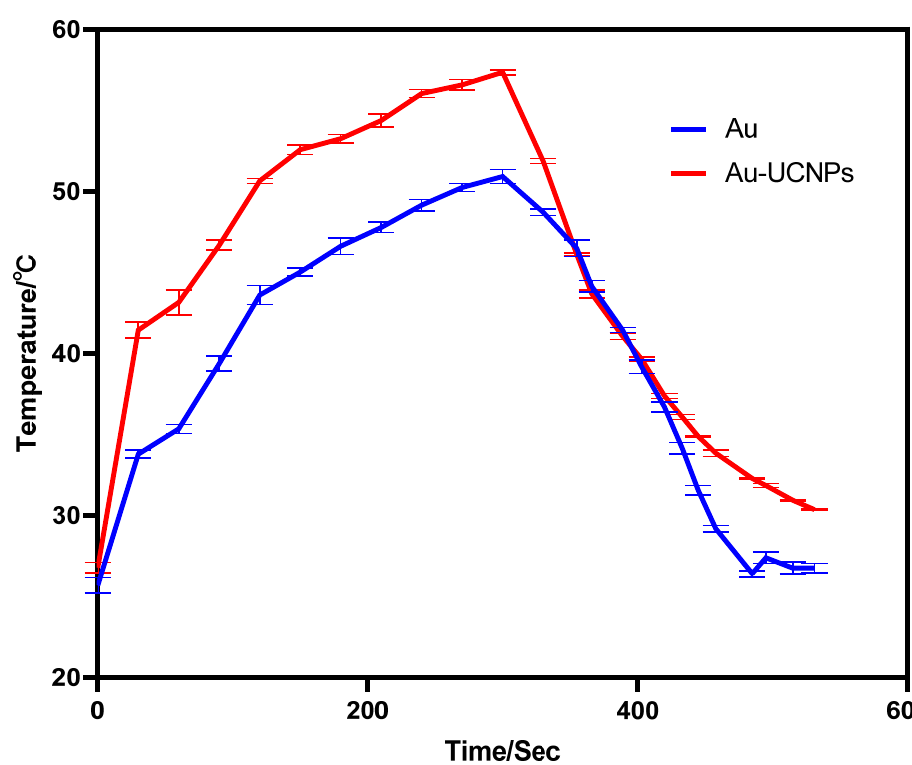
Figure 1. Temperature rise and temperature drop curves of gold nanoparticles (blue) irradiated by near-infrared light at 540 nm wavelength, and Au-UCNPs (red) irradiated by near-infrared light at 980 nm wavelength.